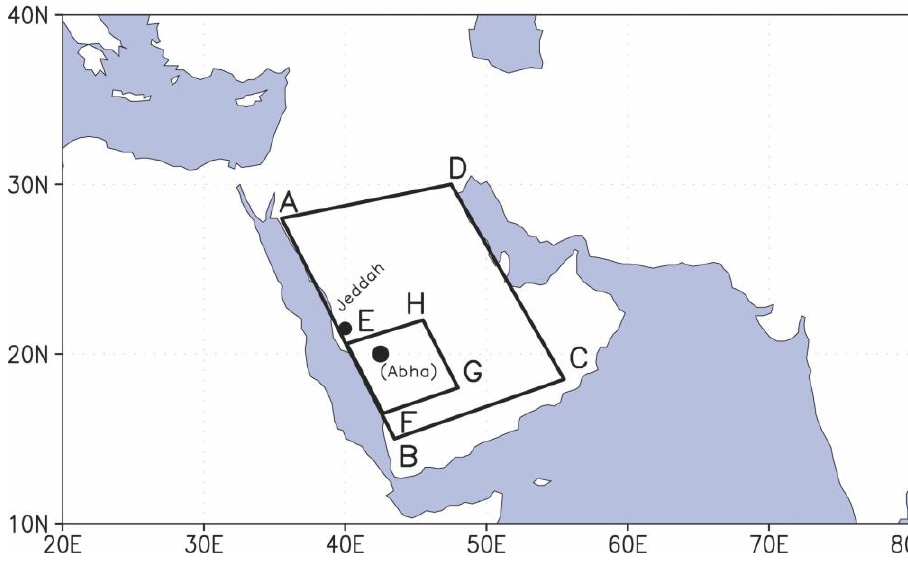
Figure 27. Domains for moisture budget analysis